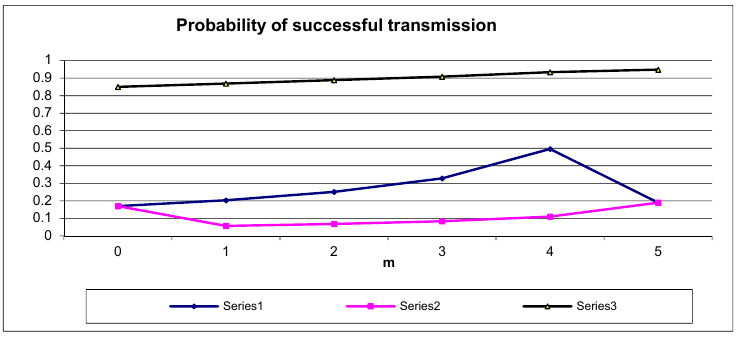
− , ),( )2( − vs. number of nodes ( m ) that occupy backlog state k 2 ( 1 ) Figure 3. Plots of ),( )1( ( n − m , m ) , p ( 2 ) ( n − m , m ) vs. number of nodes ( m ) that occupy backlog Figure 3. Plots of p )1( mmnp succ )1( mmnp succ succ ( 1 ) succ ( 1 ) and ),0( )2( according to (1), (2), (3), and ),( mmnp − according to (9) for n = 5, k 1 = 1, and k 2 = ( 2 ) succ ( 0, n ) according to (1), (2), (3), and p succ ( n − m , m ) according to (9) for n = 5, k )1( np succ state k 2 and p succ ( 1 ) 3. and k 2 =